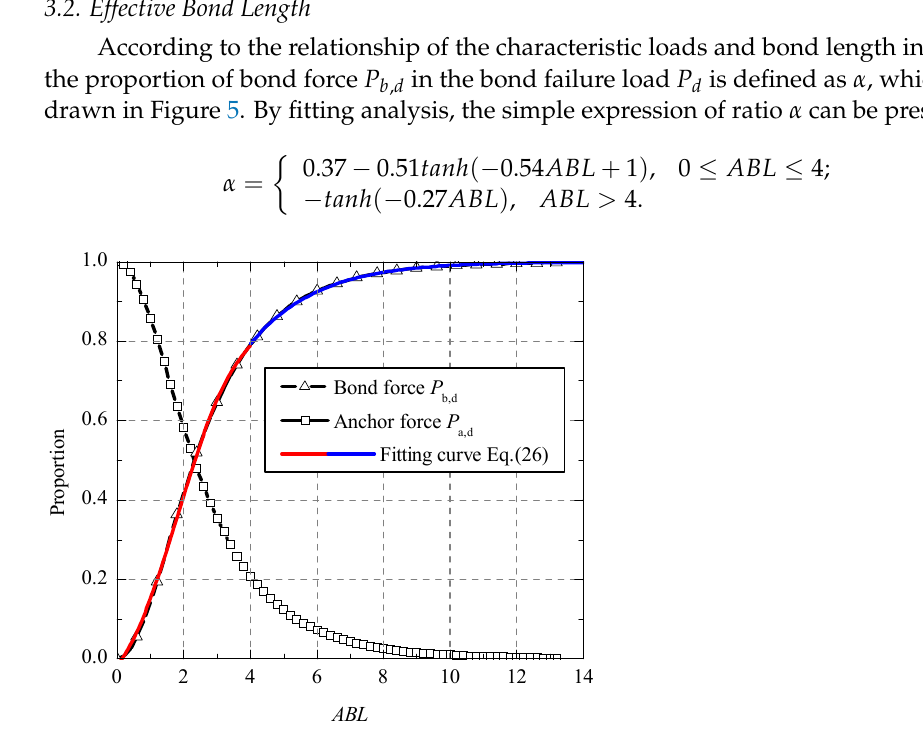
Figure 5. Load proportion curves.